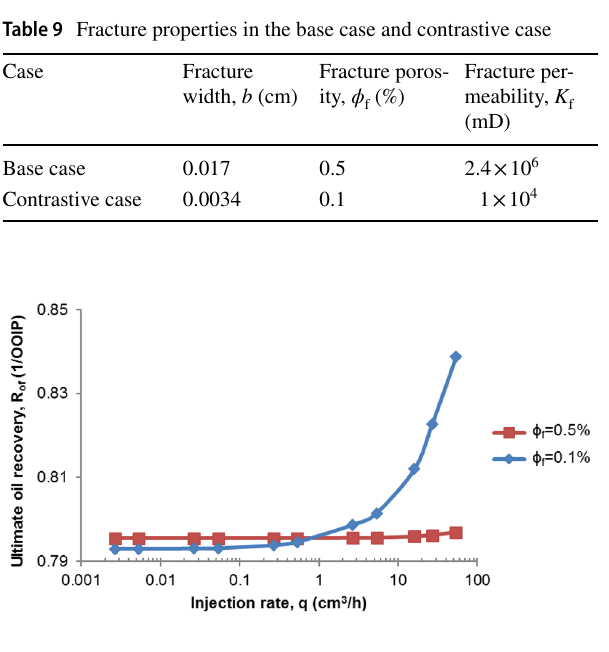
Fig. 14 The relationship between ultimate oil recovery and injection rate when the fracture porosity is 0.5% and 0.1%